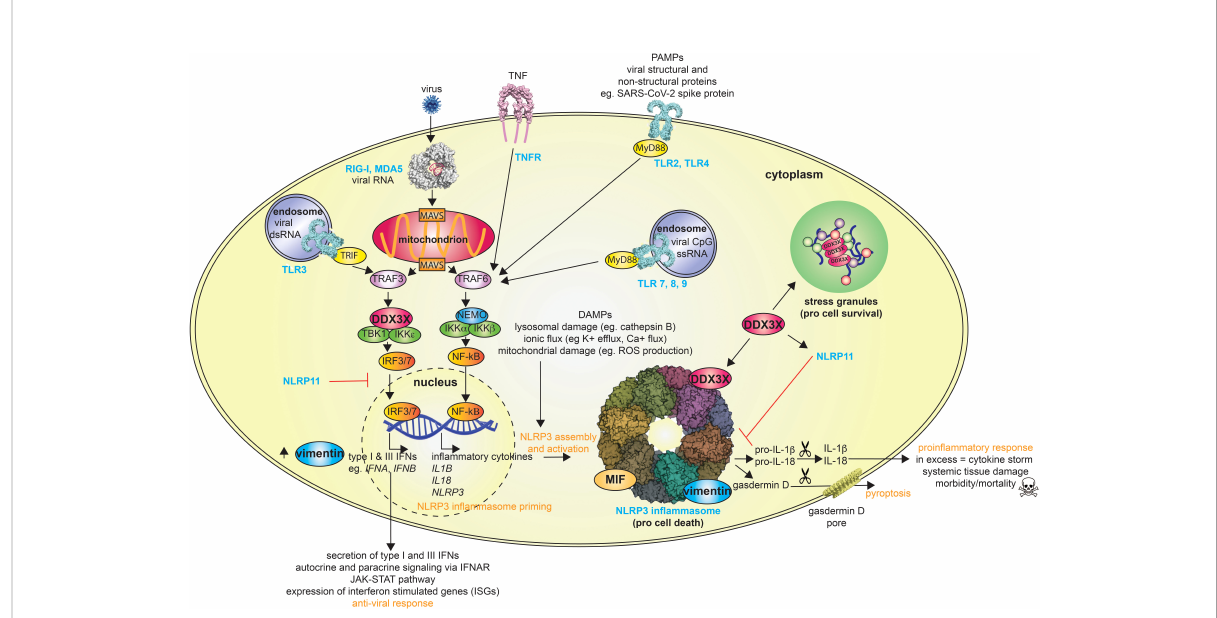
FIGURE 1 Overview of host defense following viral infection and multiple roles of DDX3X, vimentin and MIF. The scissors symbol represents enzymatic cleavage, and the upward arrow symbol indicates increased protein levels. RIG-I, retinoic acid-inducible gene I; MDA5, melanoma differentiation-associated 5; TNF, tumor necrosis factor; TNFR, TNF receptor; TRAF, TNF receptor associated factor; MAVS, mitochondrial antiviral signaling protein; TRIF, TIR domain – containing adapter-inducing interferon- b ; TBK1, TANK-binding kinase 1; DDX3X, DEAD-box protein 3X; IKK, I-kappa-B kinase; IRF, interferon regulatory factor; NF- k B, nuclear factor- k B; NEMO, NF- k B essential modulator; TLR, toll-like receptor; MyD88, myeloid differentiation primary response 88; MIF, macrophage migration inhibitory factor; NLRP, nucleotide-binding oligomerization domain (NOD)-like receptor; IL, interleukin; ROS, reactive oxygen